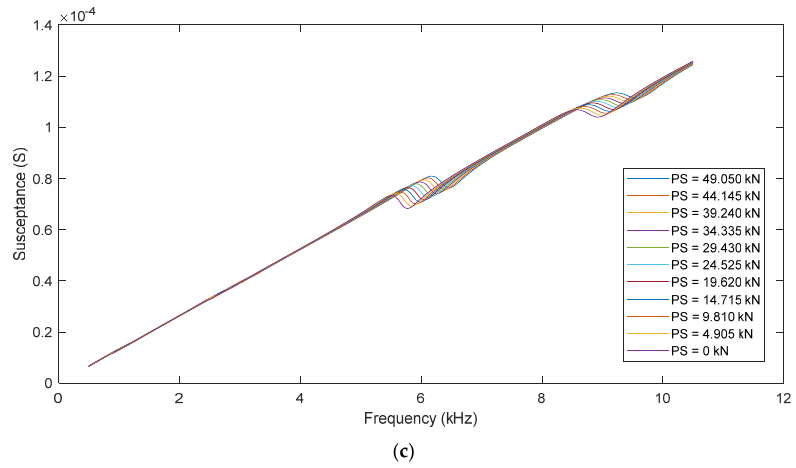
Figure 14. Impedance response: PS ‐ loss simulation. ( a ) Resistance; ( b ) Reactance; ( c ) Susceptance.